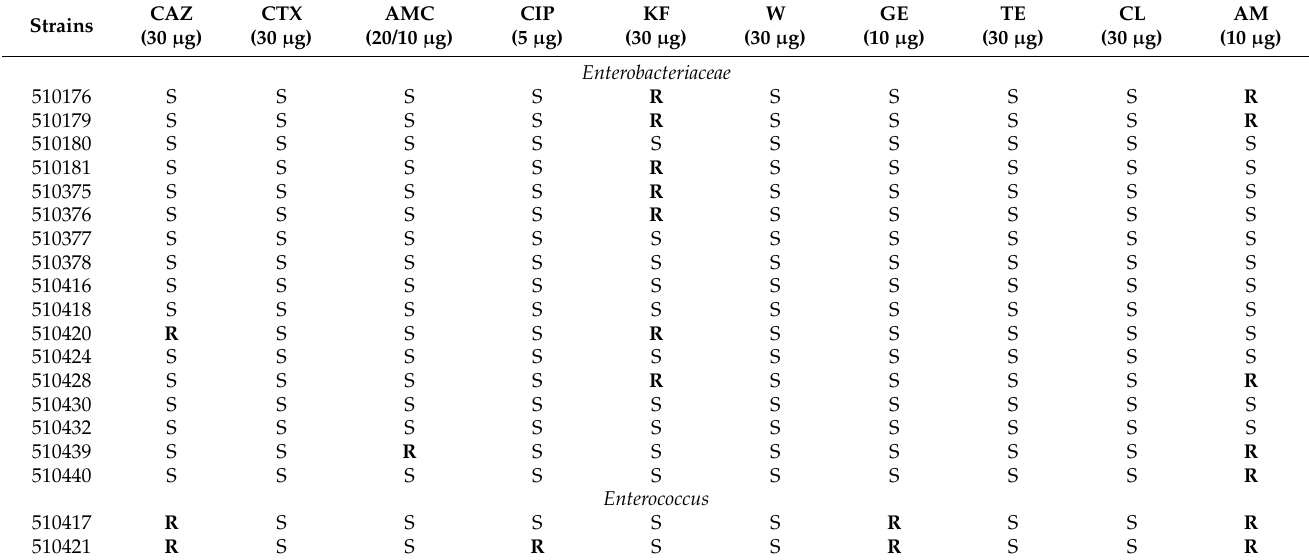
Table 2. Antibiotic resistance profiles of the Enterobacteriaceae and Enterococcus strains.